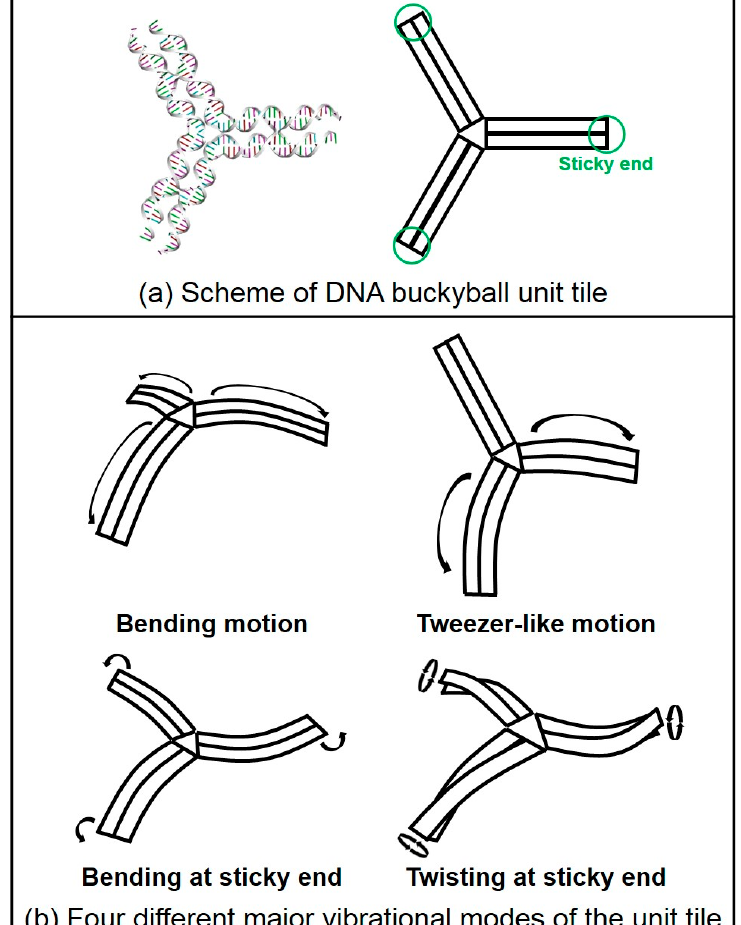
Figure 4. Schematics of three-point-star (3PS) unit tile and its major vibration modes. ( a ) Scheme of 3PS unit tile. DNA duplex is represented as a rectangle, and its three sticky ends are marked with green circles. ( b ) The unit tile shows four different major vibrational modes such as bending motion, tweezer-like motion, and bending or twisting at sticky ends. Within the 10th lowest mode, the bending motion is the 1st mode and both the 3rd and the 8th modes are tweezer-like motions. Other modes show bending, twisting or mixed bending and twisting at sticky ends.